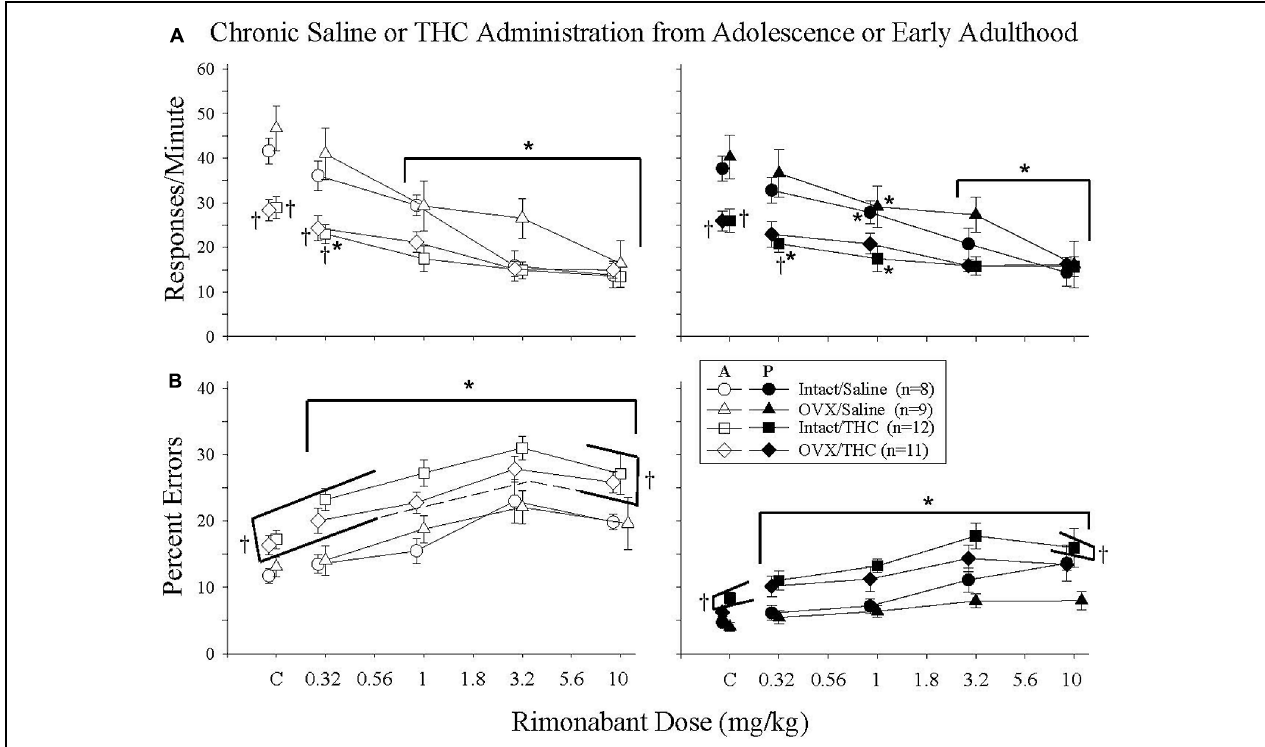
FIGURE 5 | Acute effects of rimonabant in intact and OVX females significant differences between particular doses of (cid:2) 9 -THC and acute saline that received either saline (A) or 5.6 mg/kg of (cid:2) 9 -THC (B) daily from (control) injections, whereas crosses indicate a significant difference from the adolescence or early adulthood to sacrifice and that were responding intact/saline group under control conditions or after particular doses of under an acquisition and performance procedure. The data for the two rimonabant. In the bottom panels (percent errors), there were no significant age groups were combined as there was no marked difference between interactions, only main effects for dose and treatment group. Therefore, the these age groups. Data points and vertical lines above C in each panel asterisks with brackets indicate significant differences from control injections indicate the grand mean and SEM for 3–10 vehicle (control) injections for all of the groups at every dose of rimonabant, whereas the crosses with administered to each subject in each treatment group. In the upper panels brackets indicate the treatment groups that were significantly different from (response rate), asterisks alone or in combination with brackets indicate the intact/saline group irrespective of dose. TABLE 3 | Effective rimonabant dose (i.e., ED50s) for decreasing response rate by 50% and increasing the percentage of errors by 50% in female rats chronically administered saline or (cid:2) 9 -THC from early adulthood or adolescence, as calculated from a linear regression. ED50 (mg/kg) Acquisition component Performance